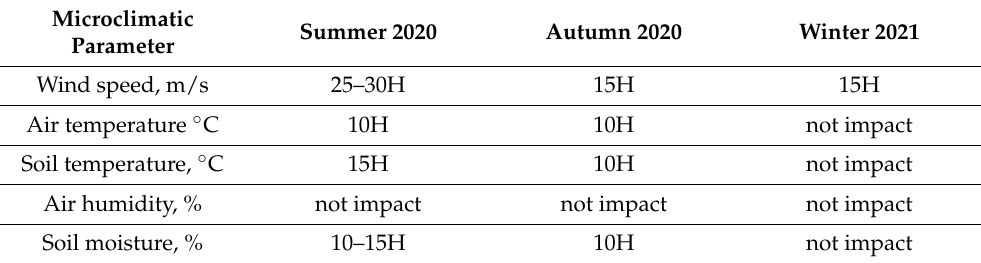
Table 1. Summary table of the impact of the forest belt on microclimatic indicators in different seasons of the